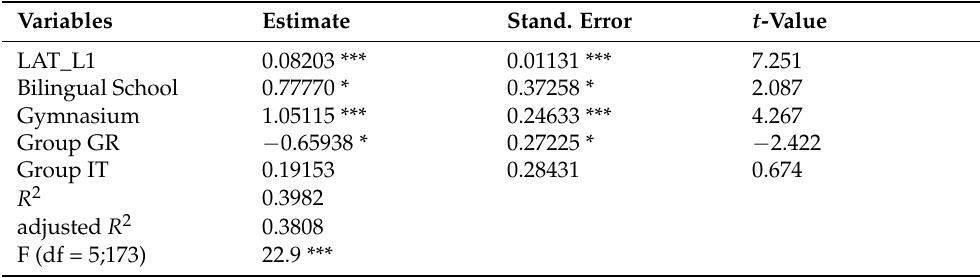
Table A3. Effects of LAT scores, school type, and language group on text competence in L1.